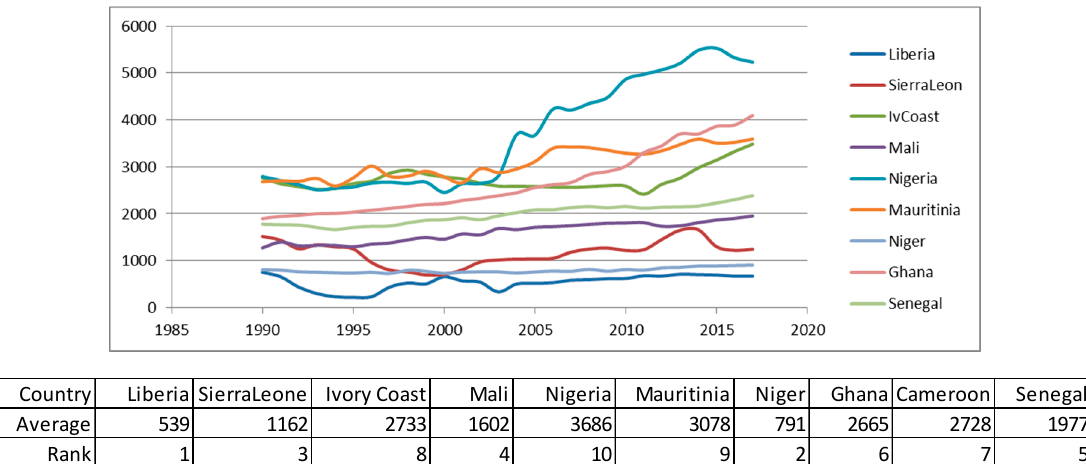
Figure A6. GNI Per Capita (1990–2017).